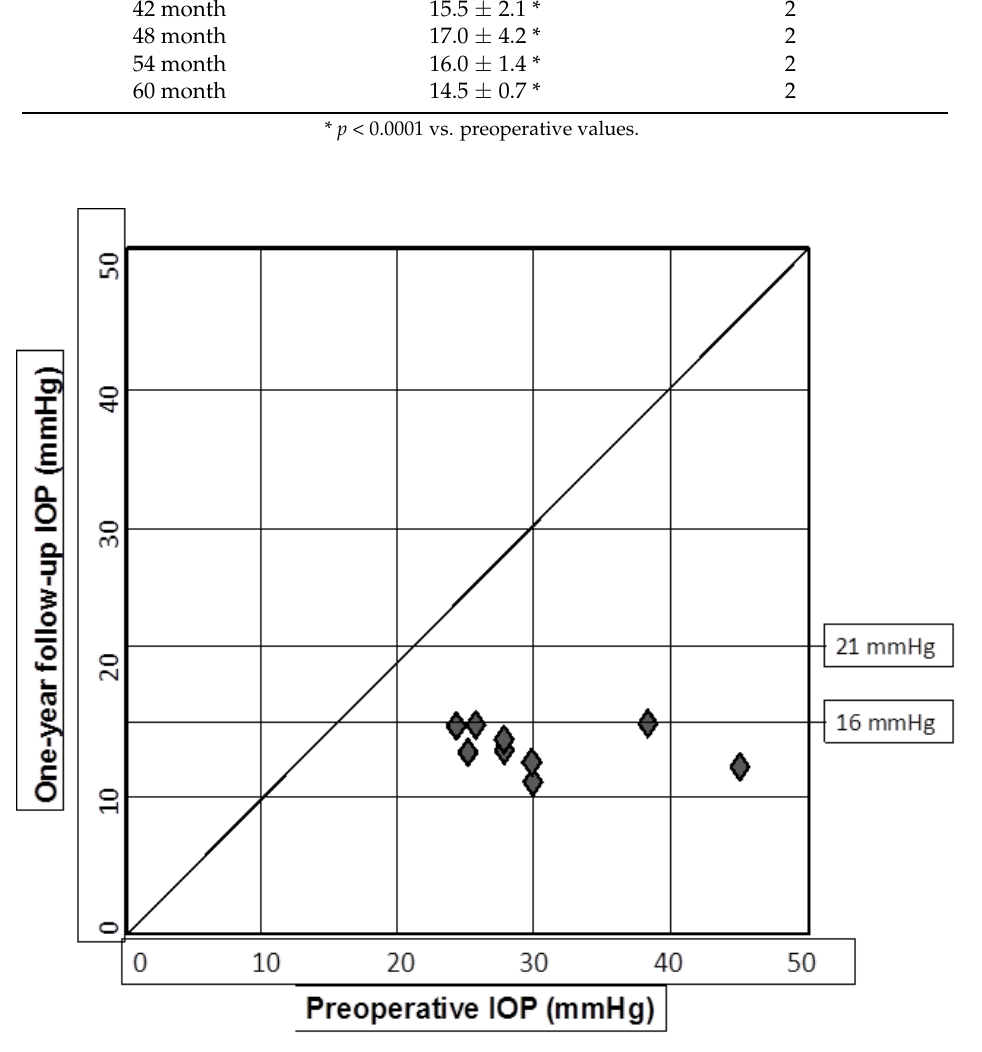
Figure 1. Pre- and one-year post-operative IOP values.